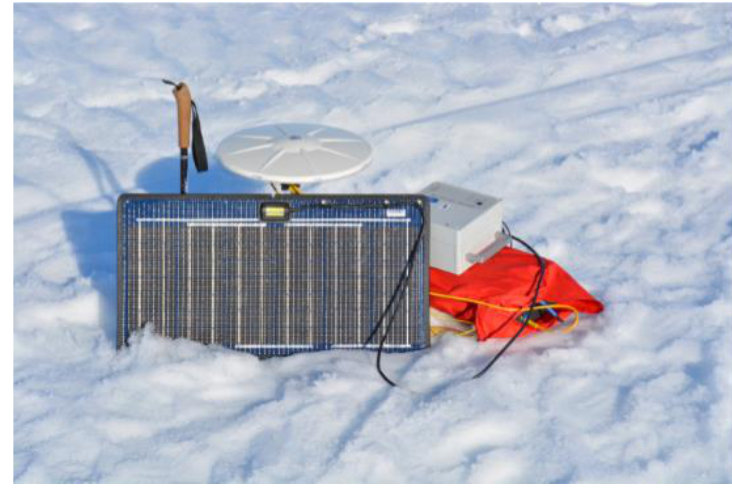
Figure 3. Static GNSS measurement during GKE 2015.